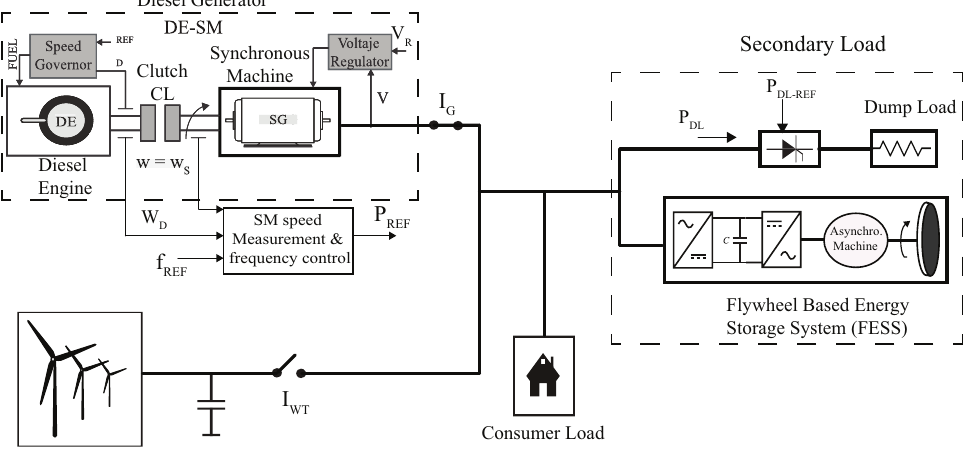
Figure 1. Wind-Diesel Power